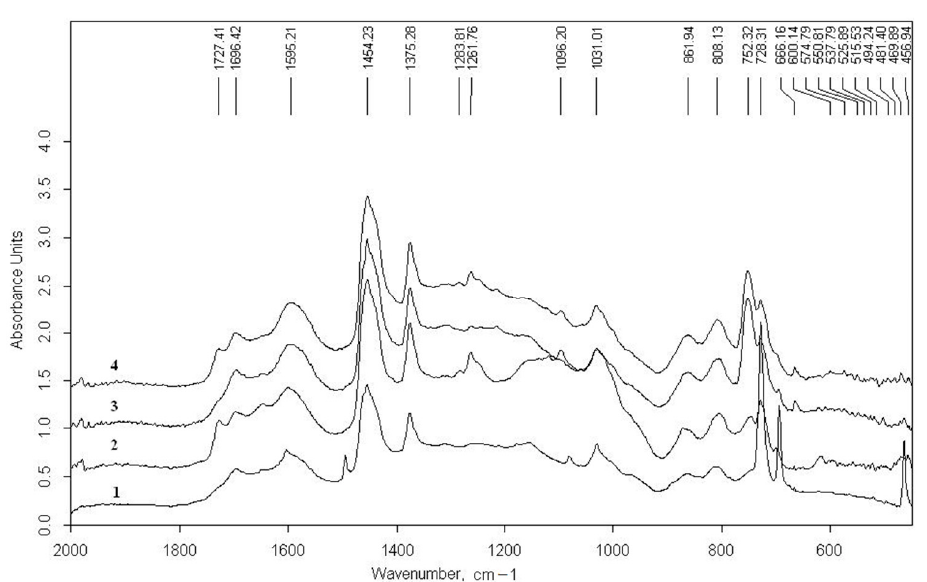
Figure 3. IR spectra of resins of oil extracts.